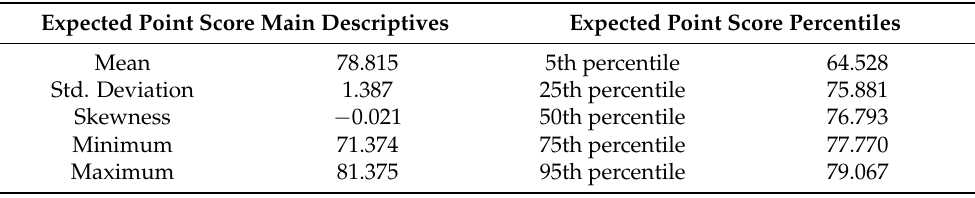
Figure 2. Question success rate histogram.